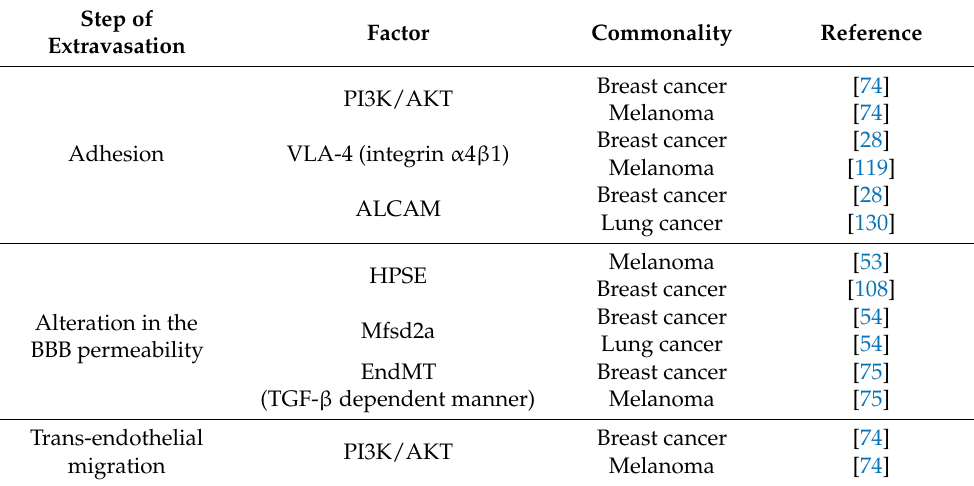
Table 5. Common factors mediating brain extravasation during brain metastasis in different types of